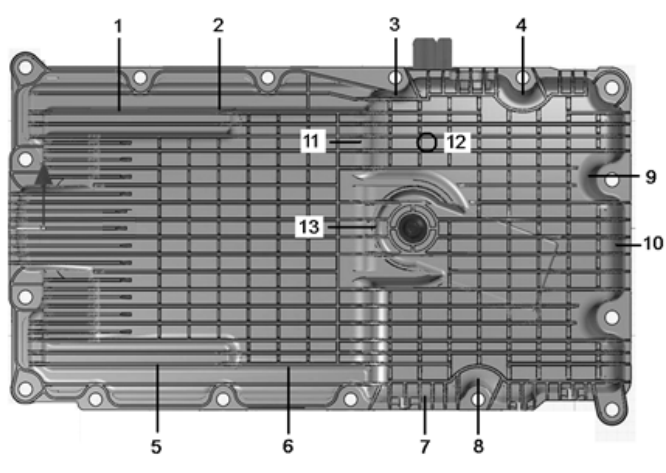
Figure 5. Map of the impact locations.